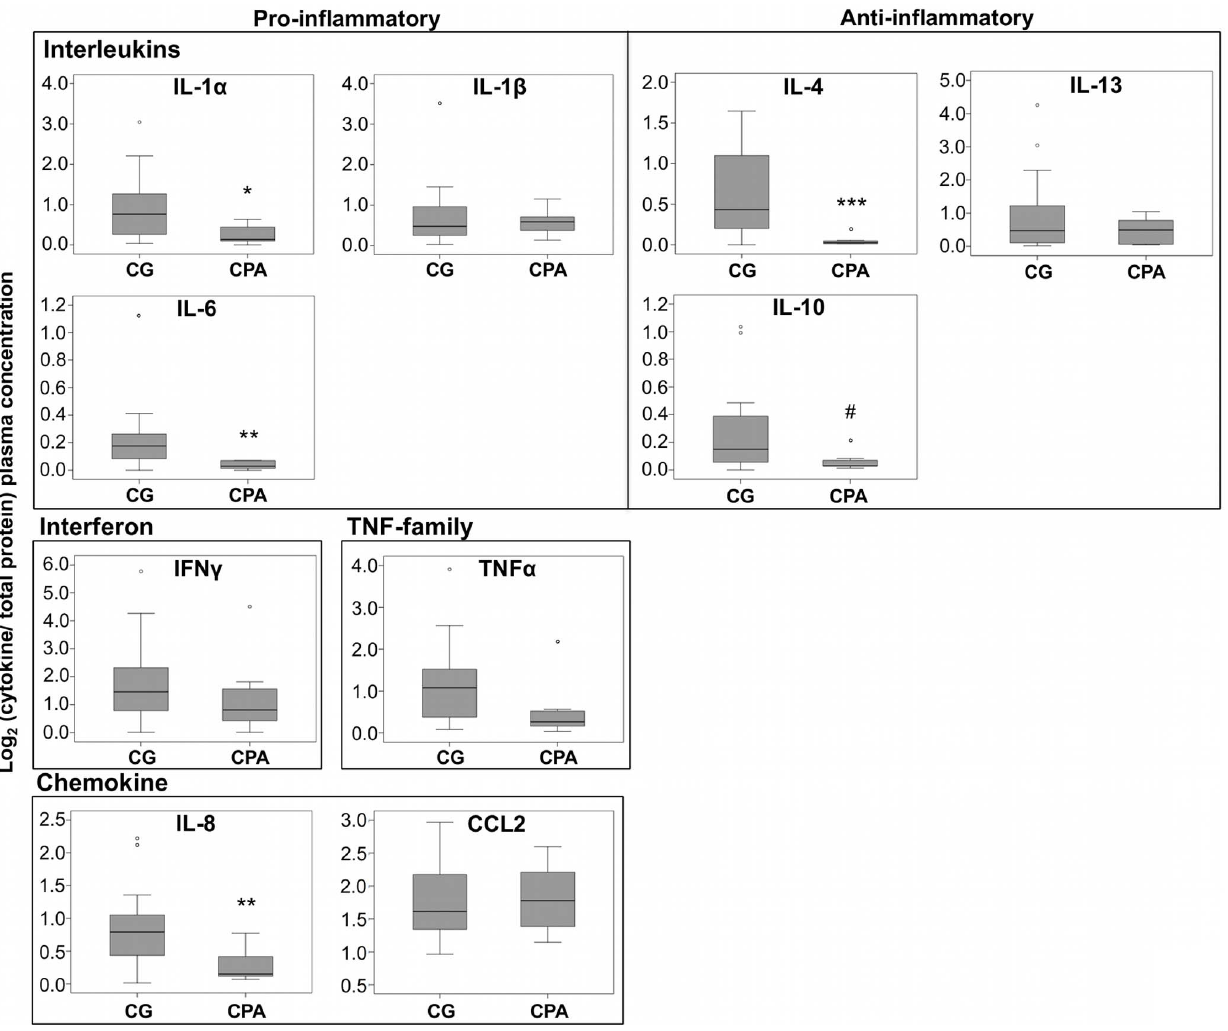
Figure 1. Decrease of IL-1 a , IL-4, IL-6, IL-8 and IL-10 concentration in plasma is observed in the CPA group (n=7) compare to the control group (n=25). Log 2 of the cytokine concentration normalized on the total amount of protein in plasma for each subject in each aggressive group is shown for 10 cytokines. Each boxplot represents the median (line), lower and upper quartiles (grey boxes), 95% confidence intervals (T-bars) and possible outliers ( u ) for each aggressive group per cytokine. Significant group difference was determined using student T-test with Bonferroni correction ( a # 0.005) and bootstrap (see methods). CPA indicates the chronic physical aggression trajectory group and CG the control group. MANOVA combining all 10 cytokines: F (10)=2.9, P =0.019. *** P # 0.0001, ** P # 0.001, * P # 0.005, # P # 0.01 from Student T-test (two-tailed).